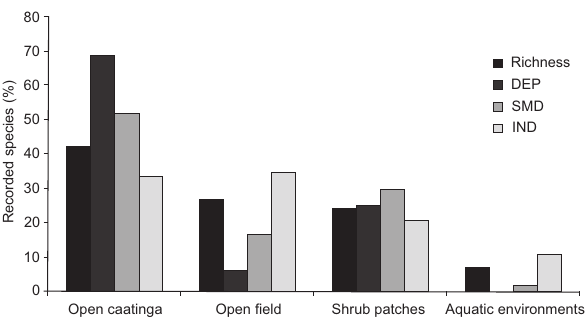
Figure 5. Percentage of species richness and their categories of habitat use in the recorded habitats. Categories of habitat use: IND. forest independent, SMD. forest semi-dependent, DEP. for- est dependent.